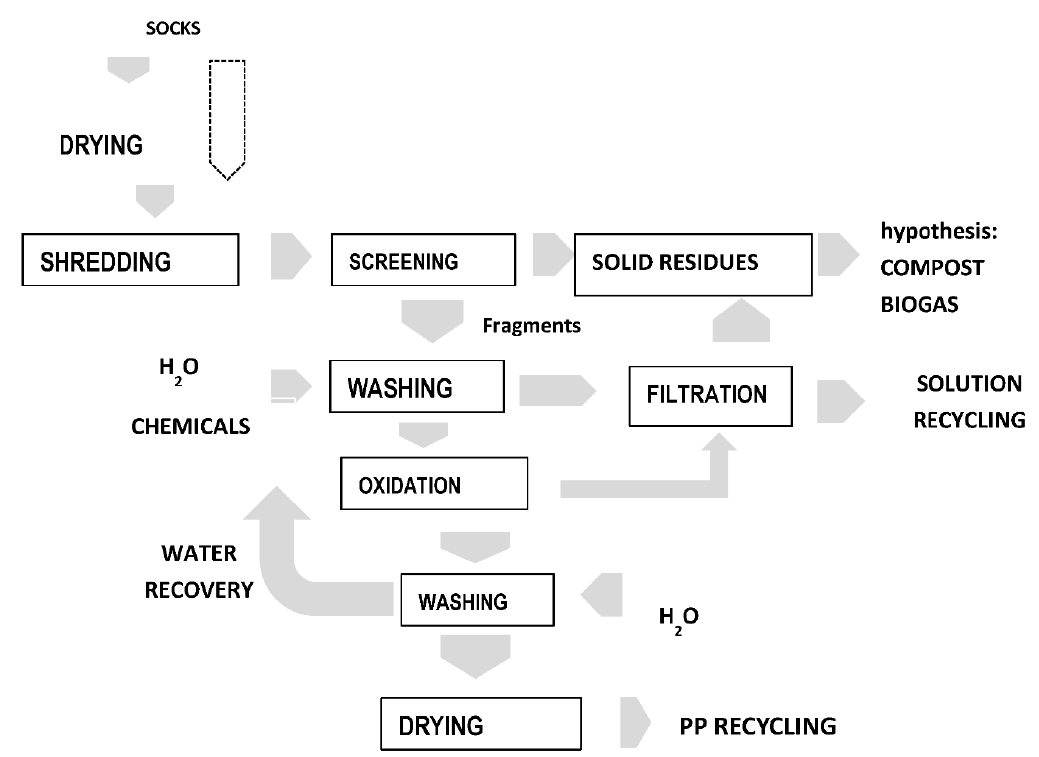
Figure 10. The process scheme.